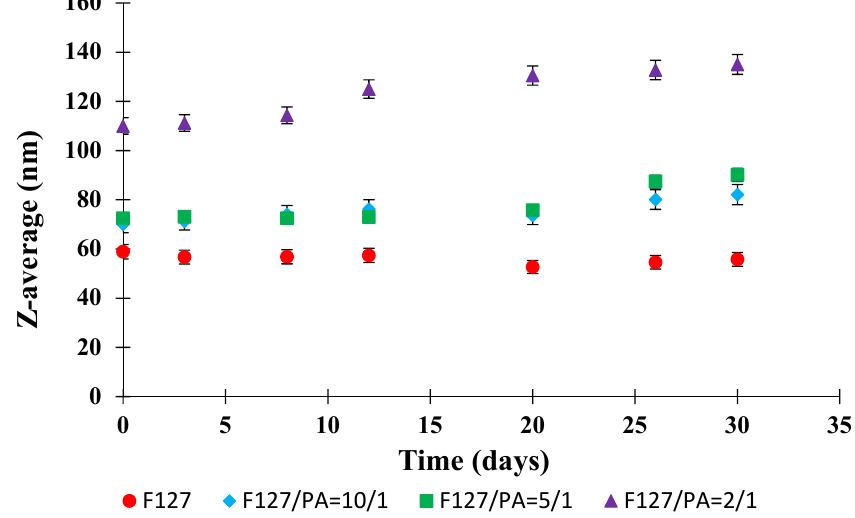
Figure 3. Evolution of the Z-average values as a function of time.